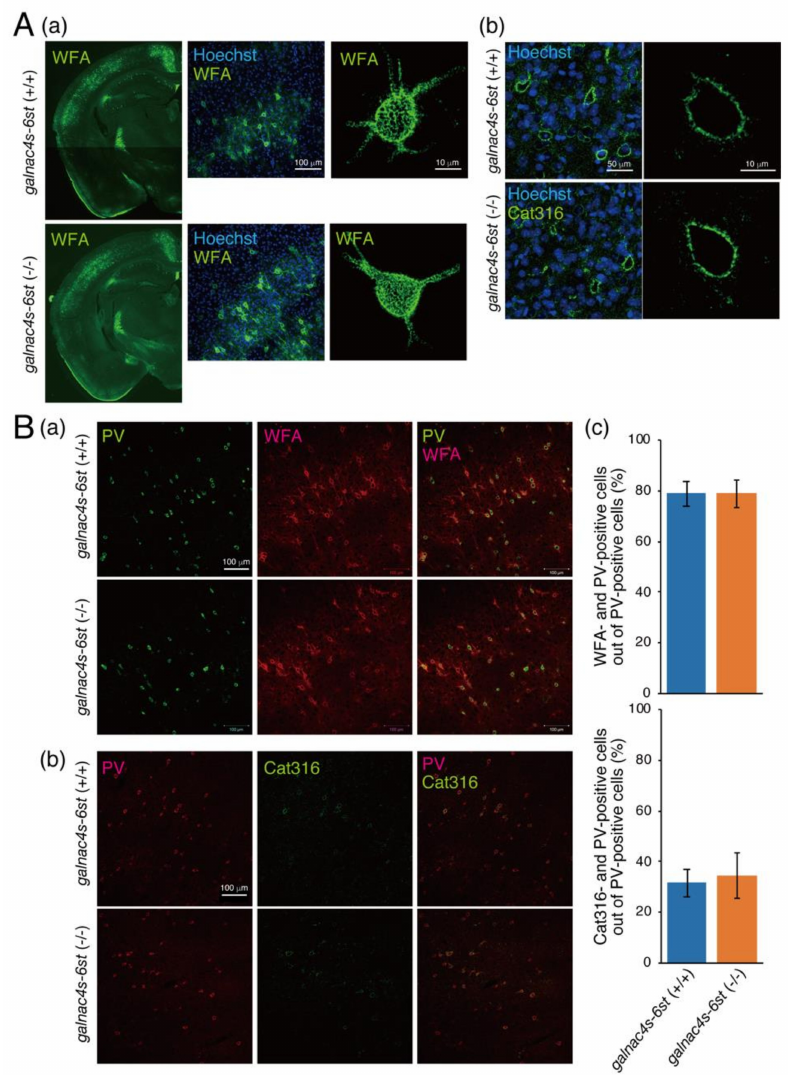
Figure 4. PNNs formed in galnac4s-6st ( − / − ) mice are comparable to those in galnac4s-6st ( +/+ ) mice. ( A ) Coronal sections from the brains of 10-week-old galnac4s-6st ( +/+ ) and galnac4s-6st ( − / − ) mice were stained with WFA ( a ) and Cat316 mAb ( b ). WFA-positive PNNs were visualized in Z-section using confocal microscopy. ( B ) PV cells and WFA-positive PNNs ( a ) as well as Cat316-positive PNNs ( b ) were immunohistochemically detected. ( c ) The percentage of PV neurons surrounded by WFA- or Cat316-positive PNNs out of PV-positive neurons was